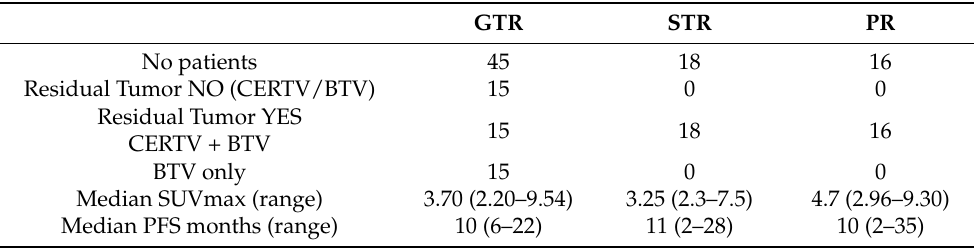
Table 3. Extent of resection (EOR), contrast enhanced residual tumor volume (CERTV), biological tumor volume (BTV), and SUVmax correlations.